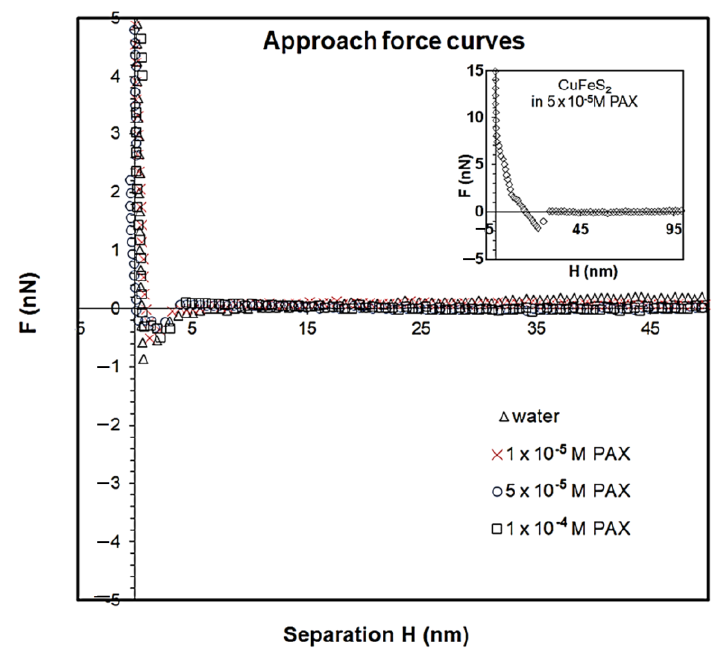
Figure 15. The approach force (F) measured between an AFM probe and a bornite plate soaked in solutions at pH 6 as a function of the separation (H) between the probe and the plate by applying an AFM force measurement. (Δ) in water; ( ×) in the 1 × 10 − 5 M PAX solution, (o) in the 5 × 10 − 5 M PAX solution and (□) in the 1 × 10 − 4 M PAX solution. The inlet (◊) shows the approach force curve obtained with CuFeS 2 in the 5 × 10 − 5 M PAX solution.